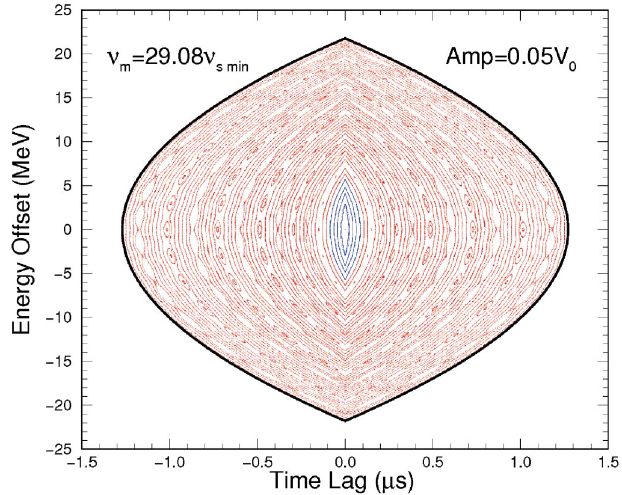
FIG. 5. (Color) Poincare´ section showing the voltage modula- (cid:1) 0 : 05 V (cid:1) and modulation tune (cid:4) tion with amplitude aV m 0 0 (or modulation frequency 60 Hz). The simulations 29 : 08 (cid:4) s; min was performed with 60 equally spaced particles on the positive time-advance axis and tracking for 5 (cid:3) 10 6 turns. Chains of resonant islands are seen well separated without any chaotic region near the center of the